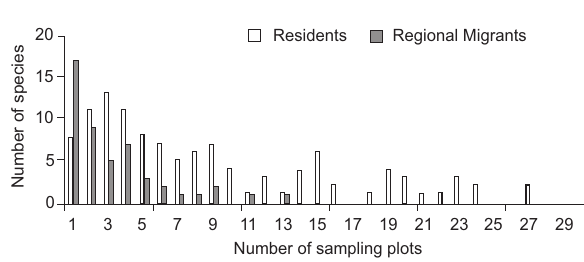
Figure 8. Number of sampling plots occupied by resident and re- gional migrant species near Poconé. Resident species were found in a significantly greater number of sampling plots than regional migrants (Kolmogorov-Smirnov test, p =